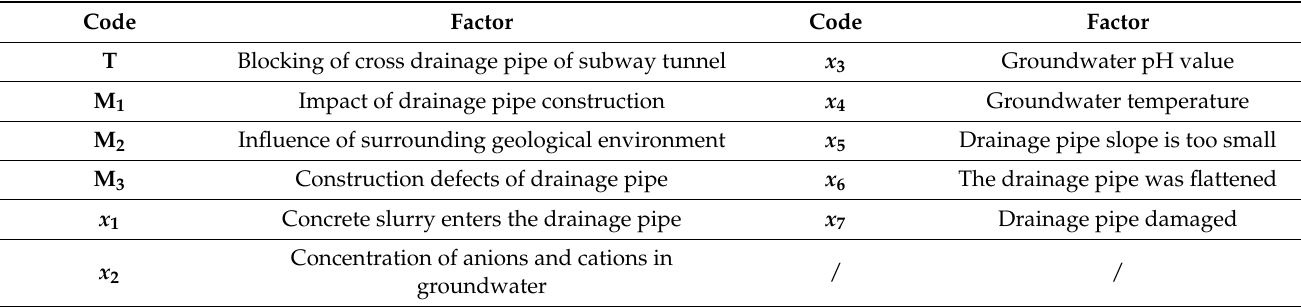
Table 3. Code factor statistics.